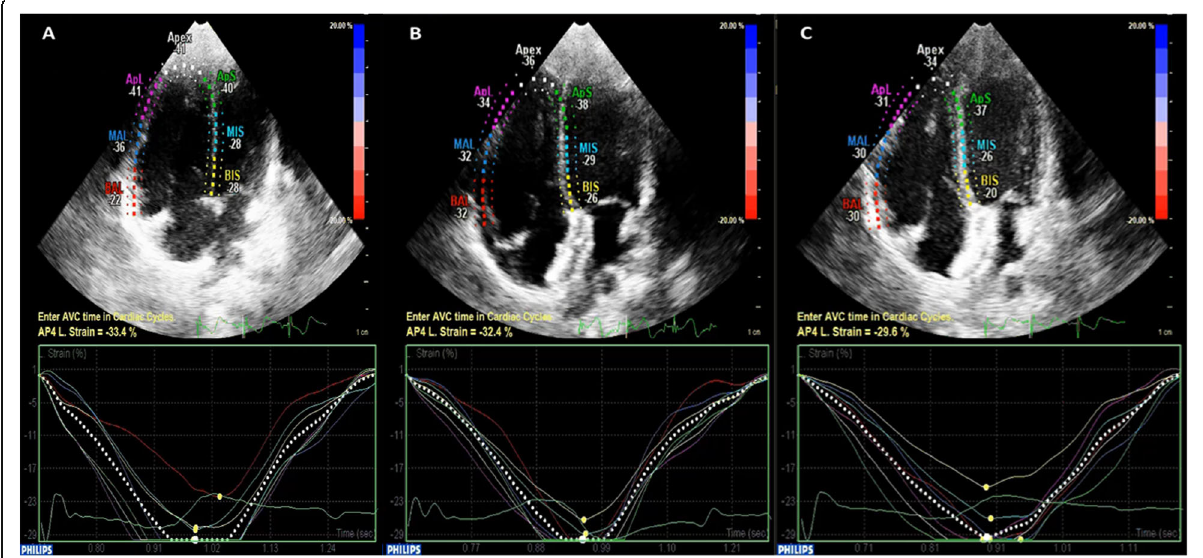
Fig. 2 2D-TTE of the RVGLS changes in an ASD case before and after device closure. a Hyperkinetic RV before ASD device closure with RVGLS in apical 4 chambers view ( − 33.4%). b Reduction in RVGLS at 24 h post-ASD device closure in the same view ( − 32.4%). c Progressive insignificant reduction in RVGLS 1 month post-ASD device closure in the same view ( − 29.6%). AP4L, apical 4 chambers longitudinal view; ApL, apical lateral; ApS, apical septum; AVC, aortic valve closure; BAL, basal anterolateral; BIS, basal inferoseptal; MAL, mid-anterolateral; MIS, mid-septum; ASD, atrial septal defect; GLS, global longitudinal strain; RV, right